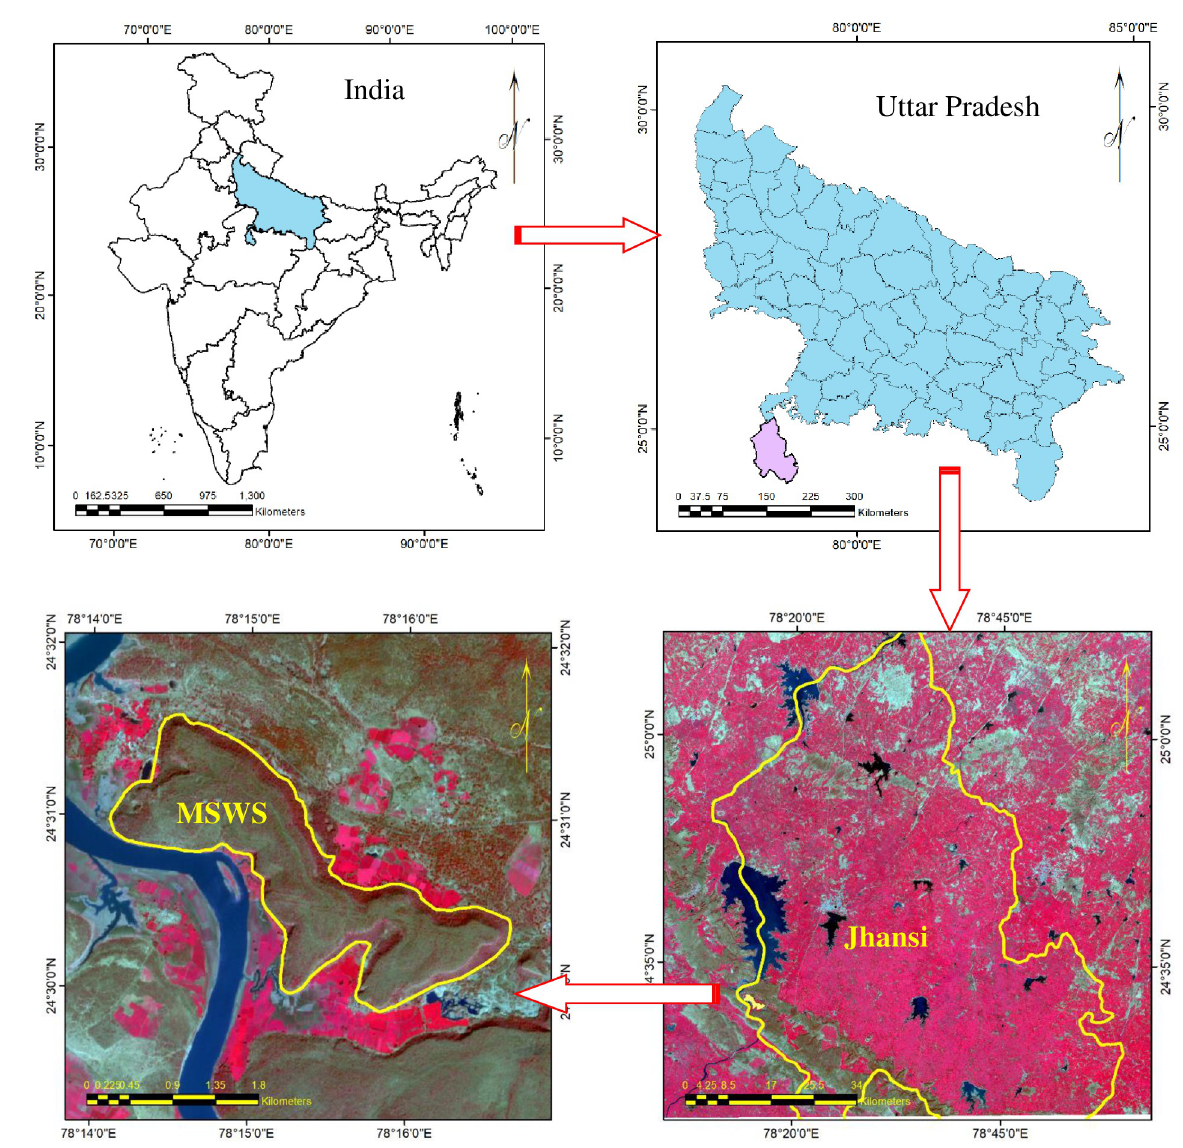
Fig 1. Study area. (Source: